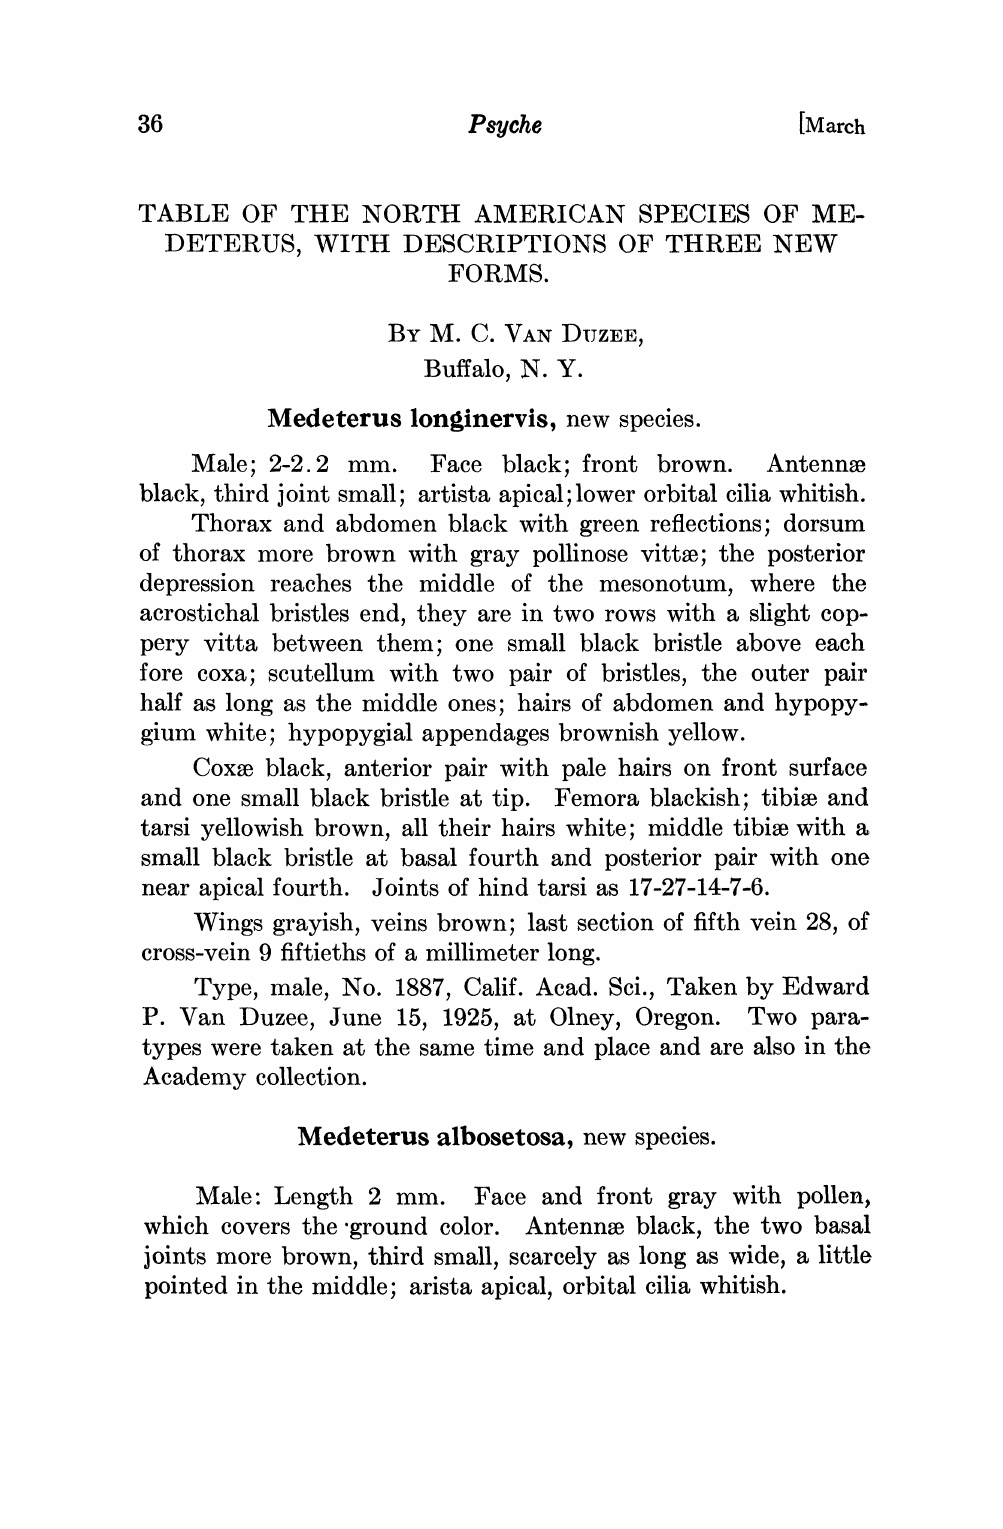
TABLE OF THE NORTH AMERICAN SPECIES OF